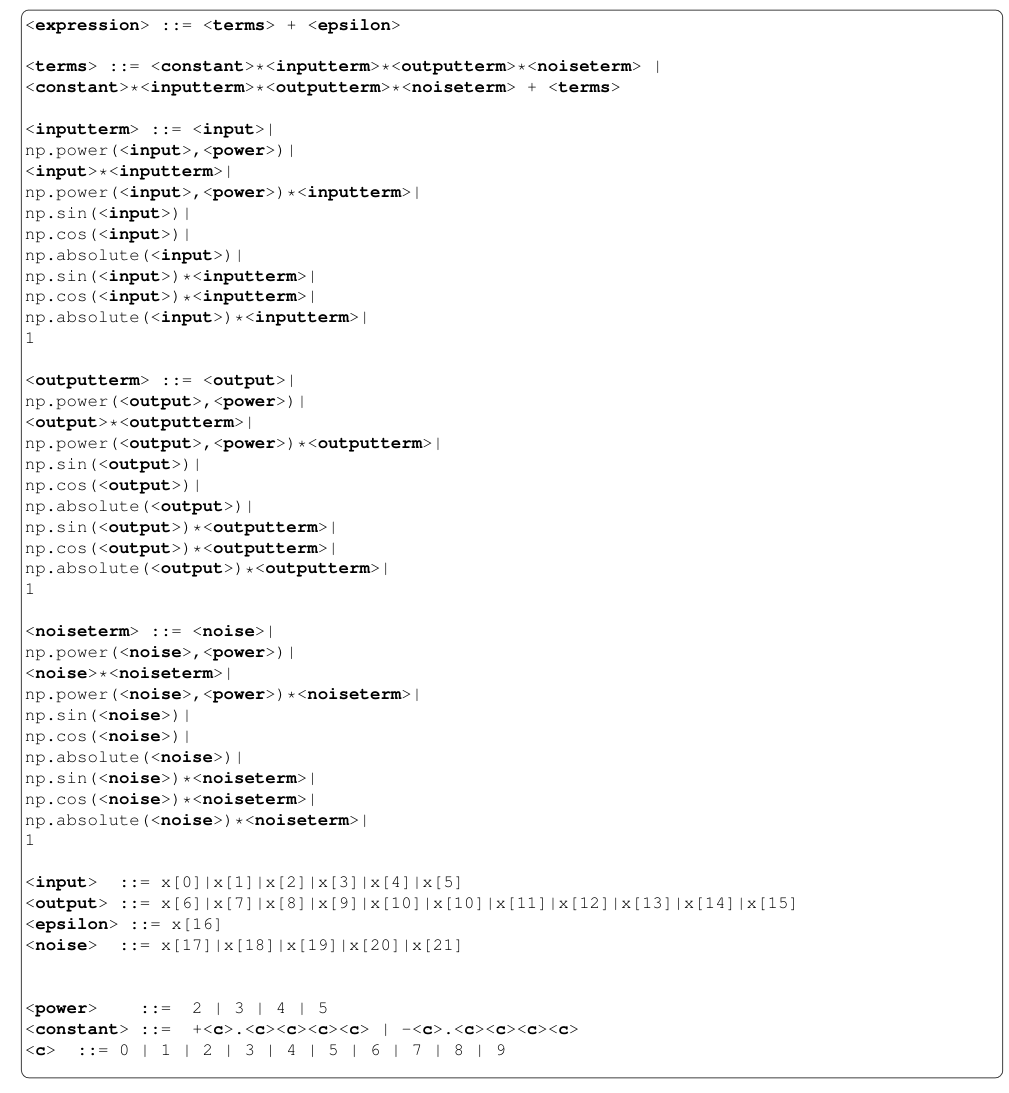
Table 6. Experimental hyperparameters for the two system identification case